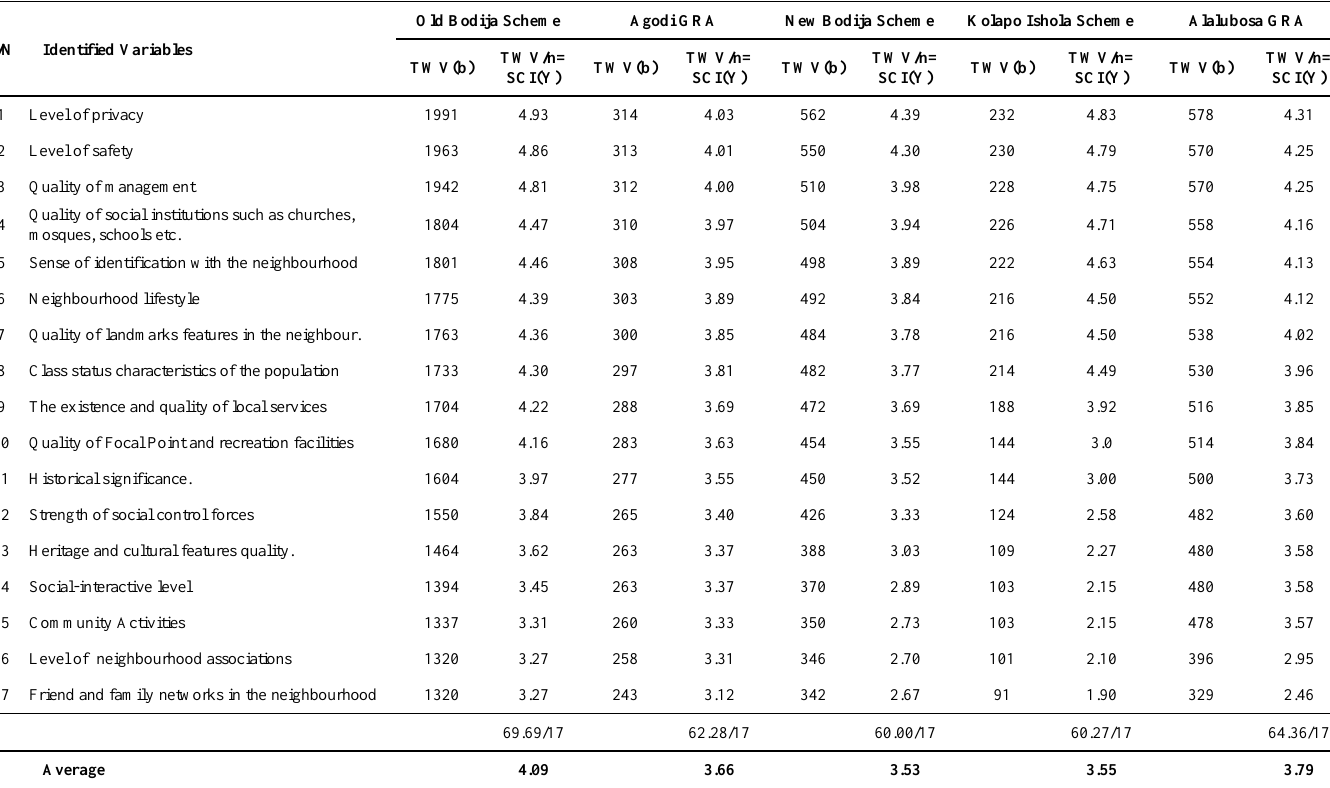
Table 12. Level of Residents’ Perception of the Neighbourhood Social Characteristics in all the study